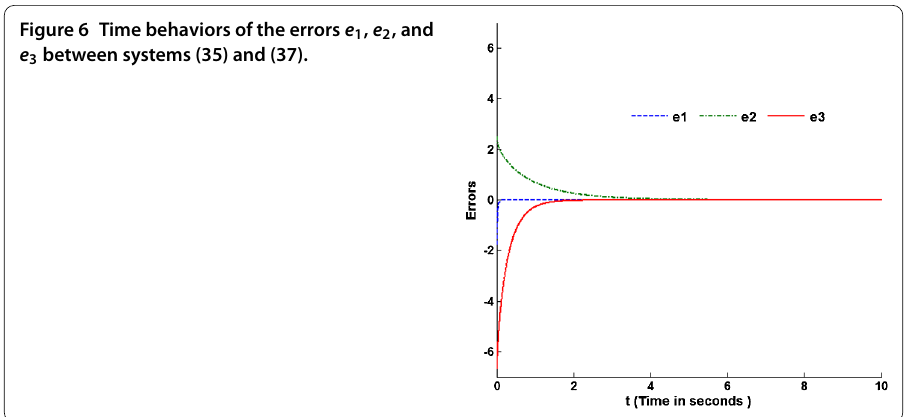
Figure 6 Time behaviors of the errors e 1 , e 2 , and e 3 between systems (35) and